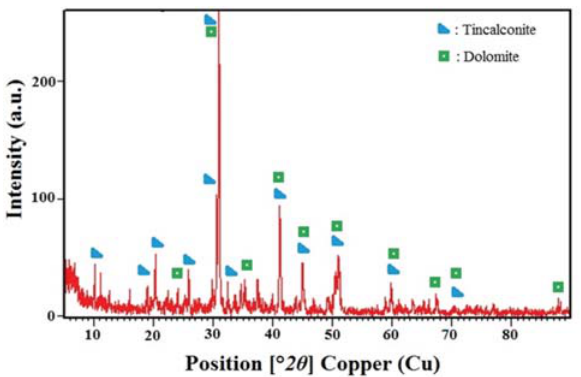
Fig. 1: XRD pattern of borax sludge According to the XRF results, the composition of borax sludge was CaO 57.3%, MgO 22%, SiO K O 0.95%. Although having boron compounds in its 2 composition, XRF showed an inability to measure the bo- ron amount because of its low molecular weight.